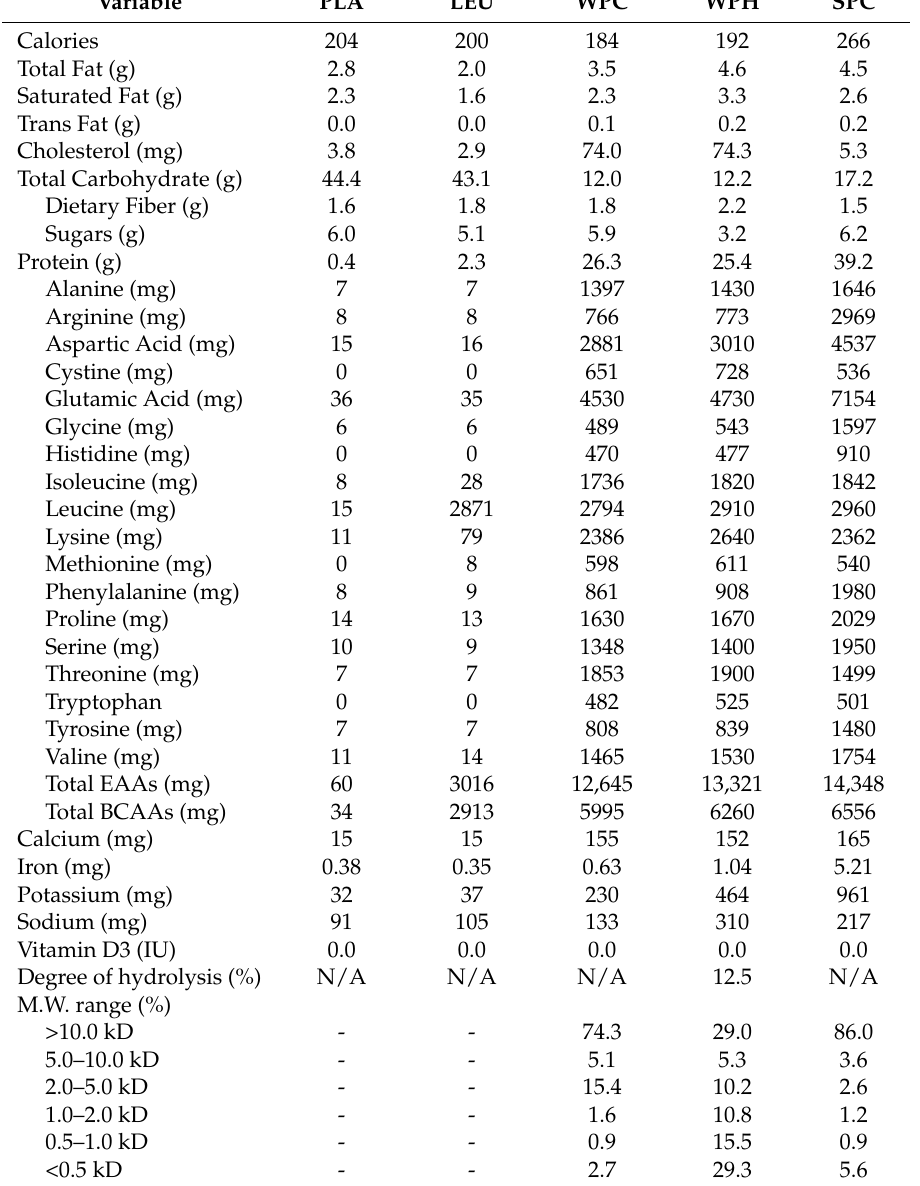
Table 2. Nutritional components per serving for the different